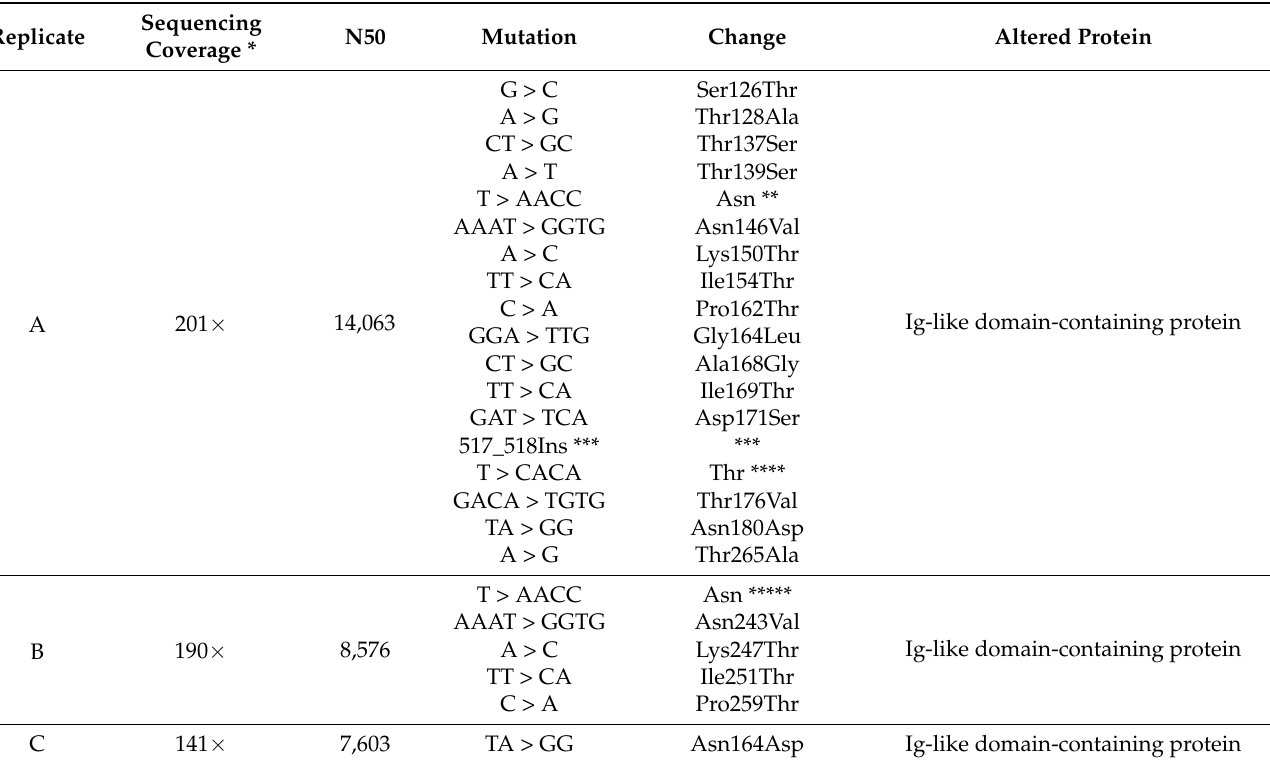
Table 7. Comparison between the initial and final strains of the A. baumannii ATCC 19606 in vitro selection with